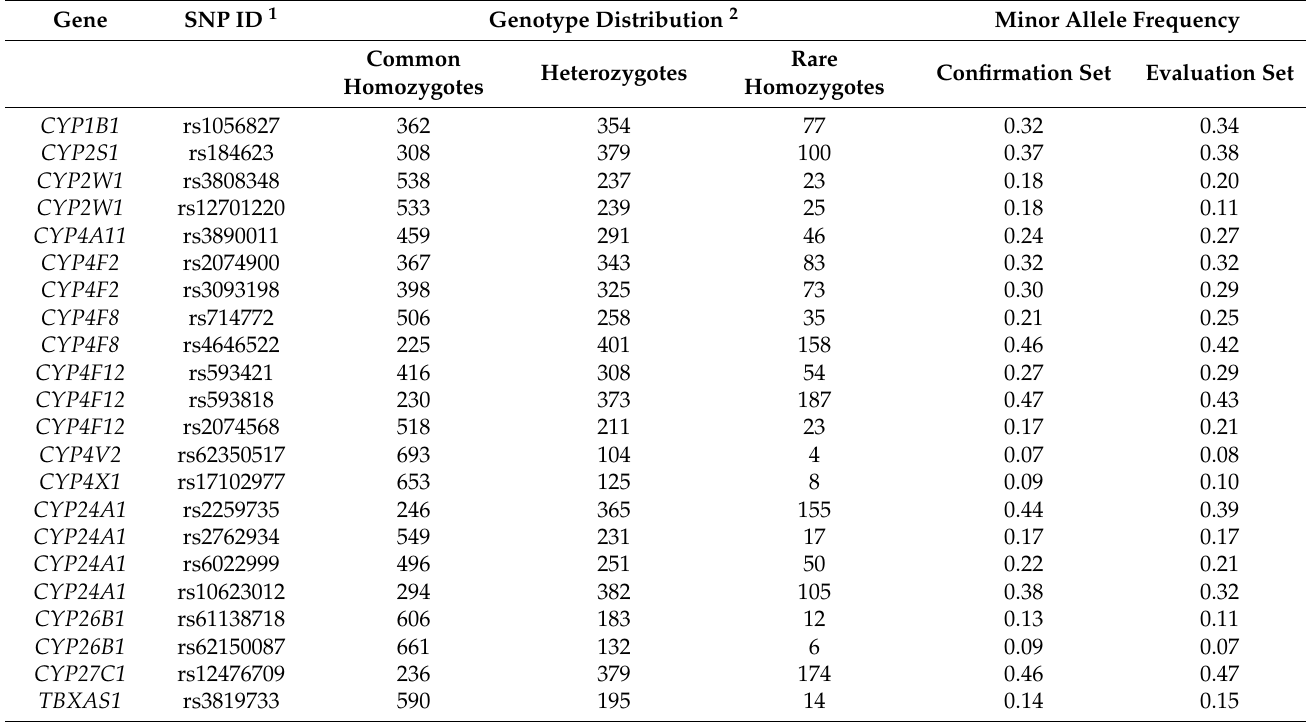
Figure 1. Distribution of alterations in individual cytochromes P450 (CYPs). The picture shows: ( a ) the frequency of genetic alterations according to their functional classes; ( b ) The frequency of genetic alterations according to their exonic functional classes analyzed by the National Center for Biotechnology Information Reference Sequence Database (https://www.ncbi.nlm.nih.gov/refseq/) (Access on: 29 September 2019); ( c ) The distribution of novel variants. Numbers of variants, normalized to the transcript length in kilobase pairs (kbp), are depicted for each gene by the overlaid line in each plot on the right axis. Table 3. Distribution of genotypes for variants assessed in the confirmation